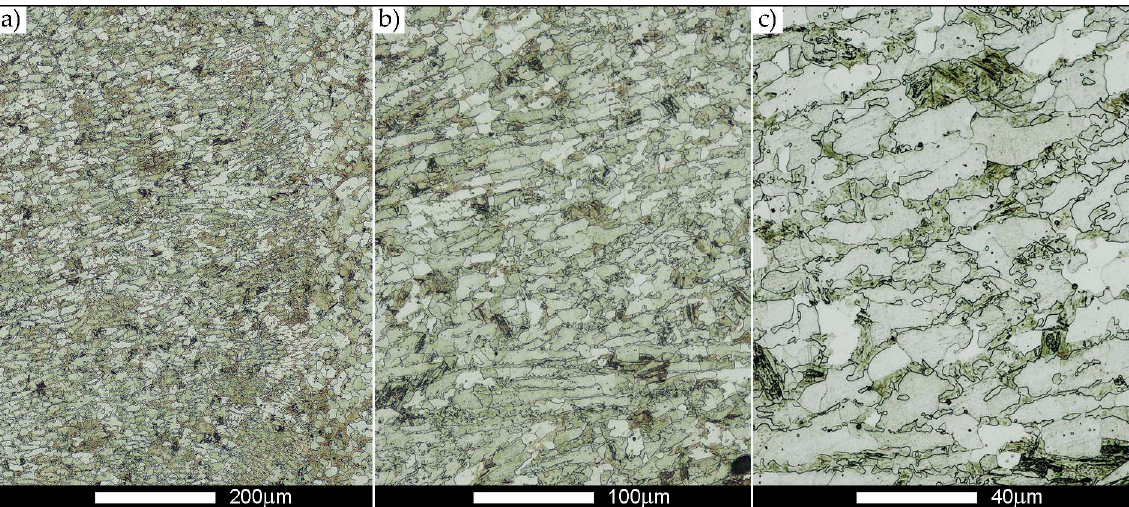
Figure 43. Welded joint microstructure of Hardox 450 in the delivery state (directly after welding) with visible prior austenite grain boundaries—WM3 zone shown in Figure 2. ( a ) 100×; ( b ) 200×; ( c ) 500×.